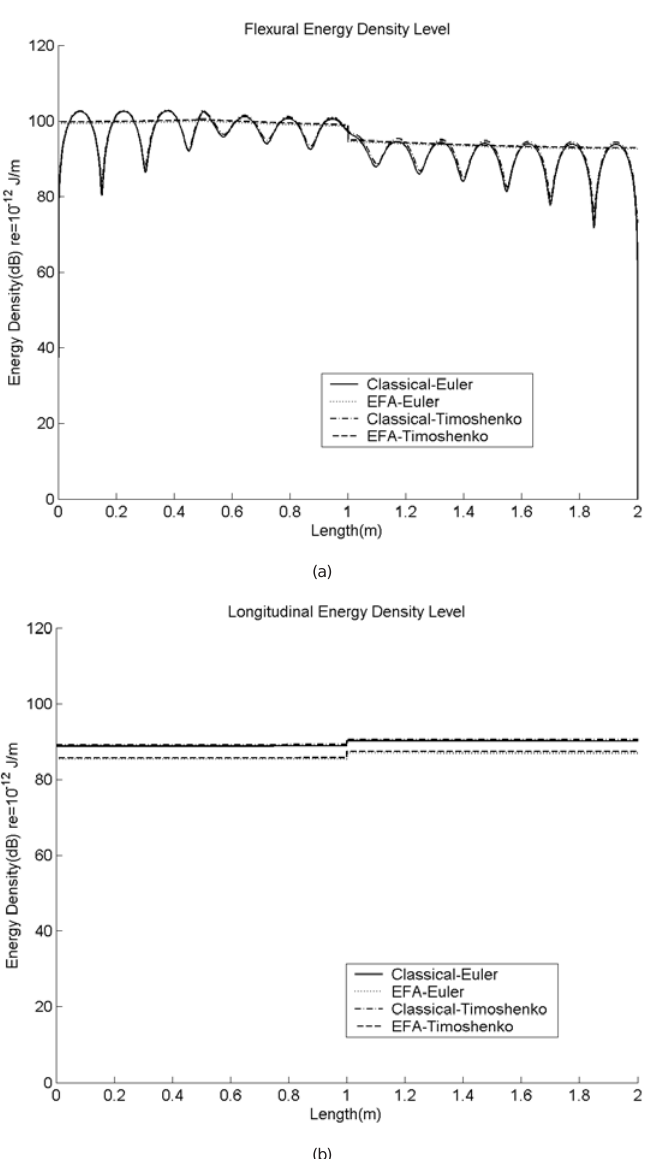
Fig. 13. The comparison of the time- and locally space-averaged energy and power levels of two Timoshenko beam with two Euler-Bernoulli beam structures coupled with θ = 45 ◦ when f = 1 kHz, η = 0 . 1 . The reference energy density is 1 × 10 − 12 J / m and the reference power is 1 × 10 − 12 W; (a) Flexural energy, (b) Longitudinal energy, (c) Flexural power, (d) Longitudinal